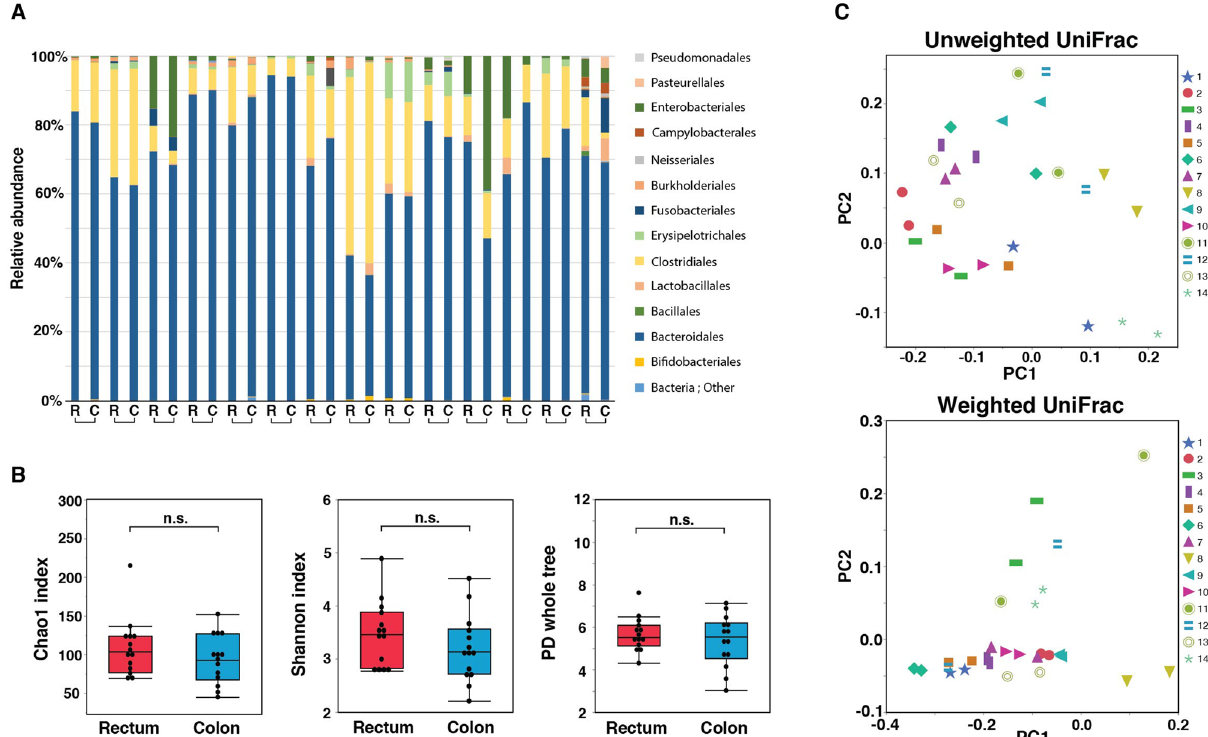
Figure 1. Comparison of gut microbiota composition between rectum and colon in patients with ulcerative colitis (UC). (A) Bar graph of the gut microbiota composition of the rectum (R) and colon (C) in the patients with UC at the order level. The brackets underneath indicate one individual. (B) Comparisons of α-diversity of gut microbiota composition between rectum and colon as assessed by the Chao1 index, the Shannon index, and whole-tree phylogenetic diversity (PD). (C) Principal coordinate analysis of gut microbiota by unweighted and weighted UniFrac between the rectum and colon. Each symbol indicates one patient. n.s., no significant difference between the 2 indicated groups (PERMANOVA, p =